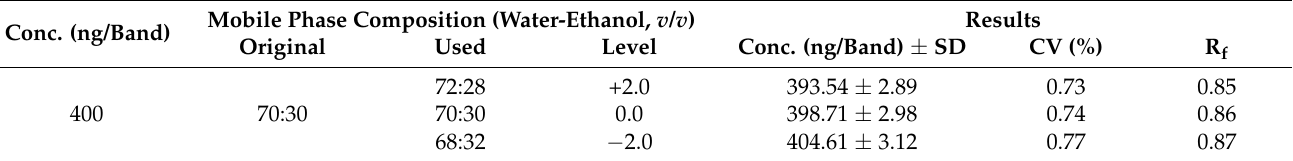
Table 5. Robustness analysis for AA for the greener HPTLC method a